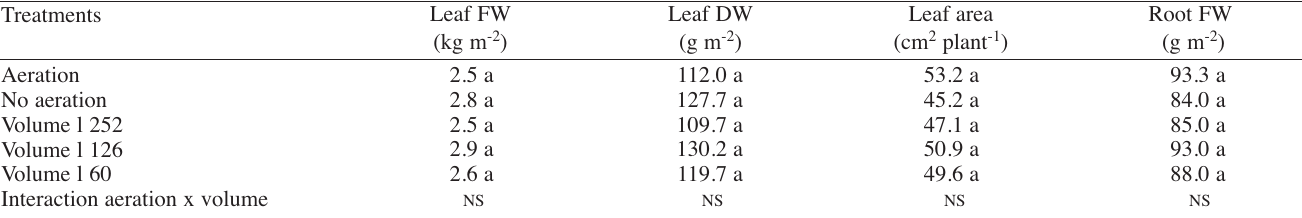
Table 2 - Effect of aeration and volume (l per m 2 of cultivated area) of the nutrient solution on leaf production (leaf FW and leaf DW), leaf area and root production (root FW) in spinach grown in a floating system in the autumn season